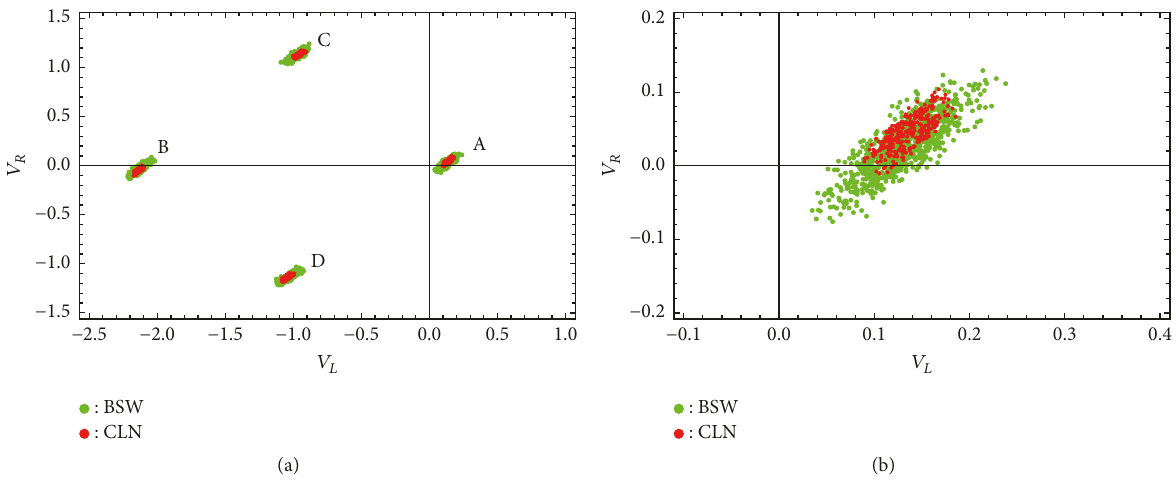
Figure 1: The allowed spaces of 𝑉 𝐿 and 𝑉 𝑅 obtained by fitting to 𝑅 𝐷 and 𝑅 𝐷 ∗ . The red and green regions are obtained by using the form factors of CLN parametrization and BSW model, respectively. (b) shows the minimal result (solution A) of the four solutions shown in